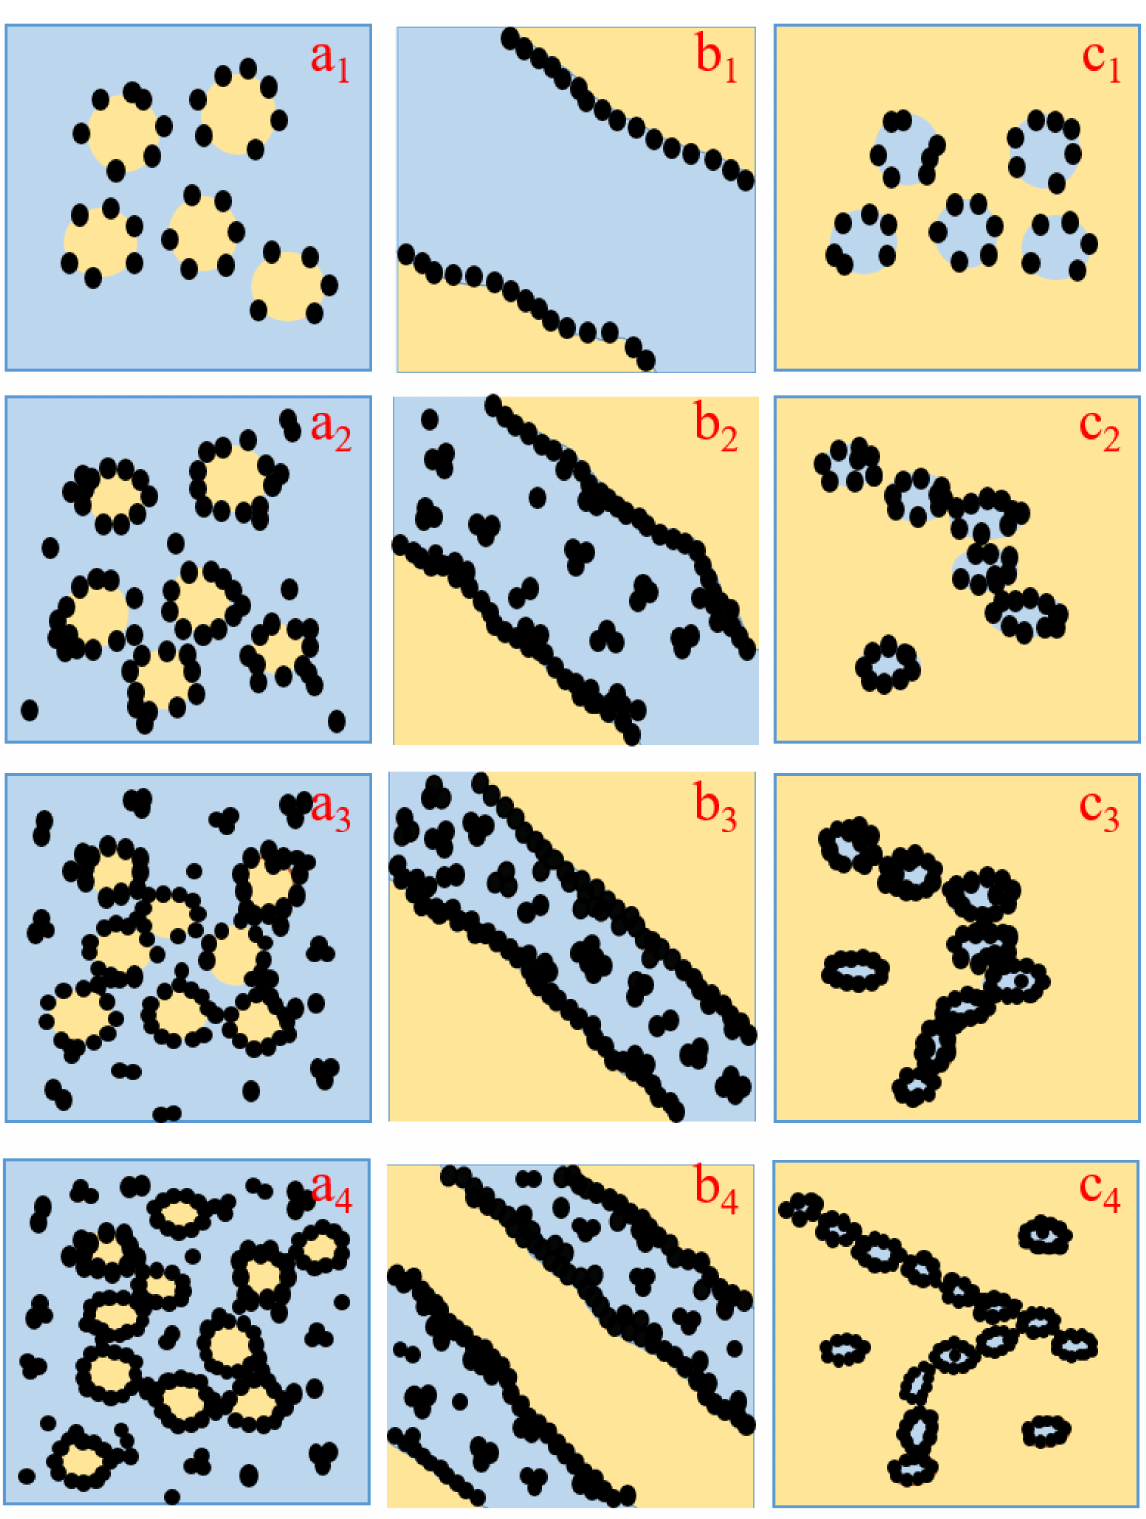
Figure 7. Illustration of the proposed mechanisms for the formation of different percolated CB networks in three different PA6/PBT blends: 80/20 ( a 1 , a 2 , a 3 , a 4 ), 50/50 ( b 1 , b 2 , b 3 , b 4 ) and 20/80 ( c 1 , c 2 , c 3 , c 4